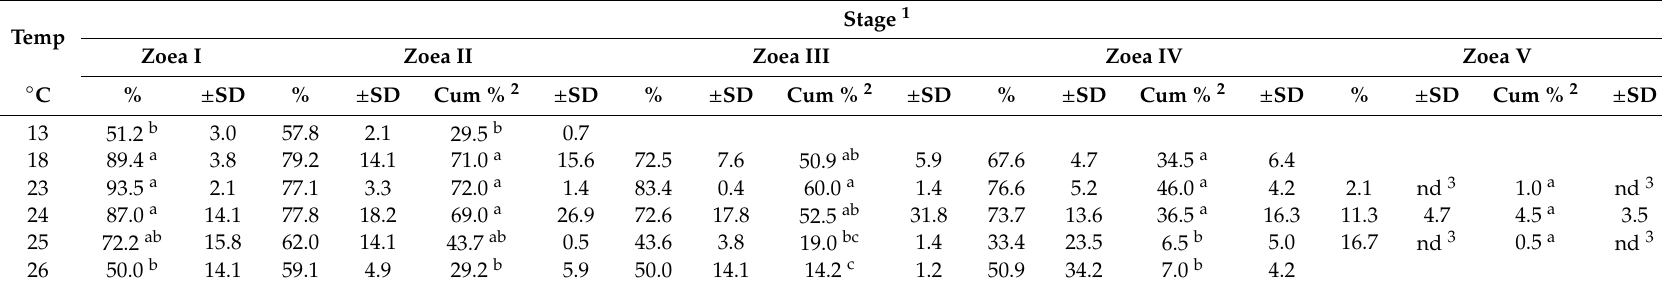
Table 1. Mean survival rates ( % of survivors for a given stage) of D. japonicus to reach each larval stage reared under di ff erent temperature conditions.